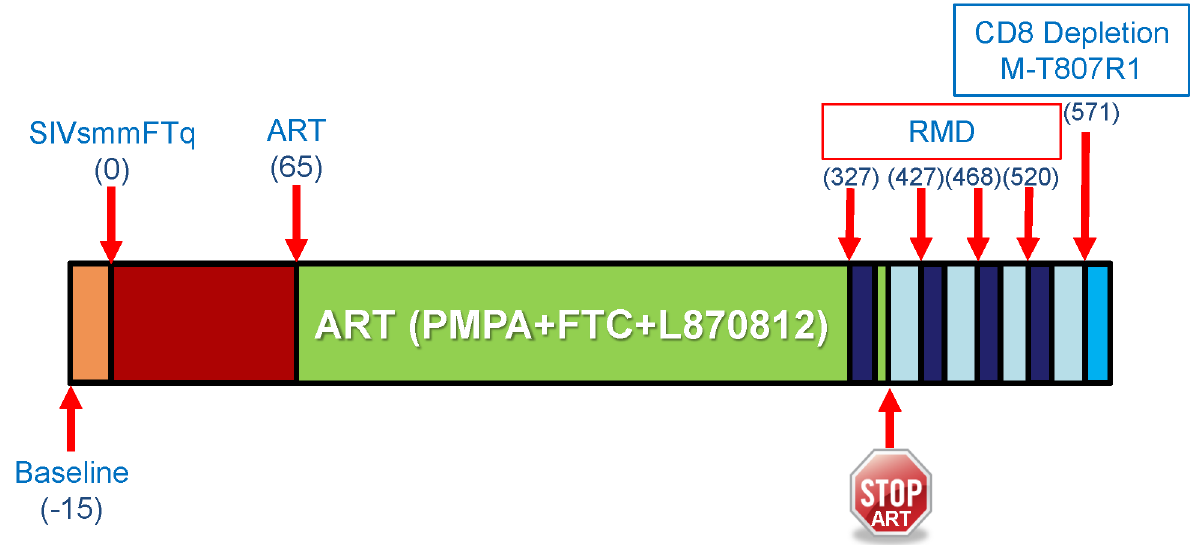
Fig 1. Study design. The timeline of the study indicates the days in which SIVsmmFTq infection was performed, ART was initiated, RMD was administered, as well as the experimental time point of the CD8 + cell depletion with M-T807R1 mAb. Sampling time points are not shown, as only blood was collected in this study and the time points of blood collection are too numerous to be shown. Please refer to the method section for information regarding the sampling